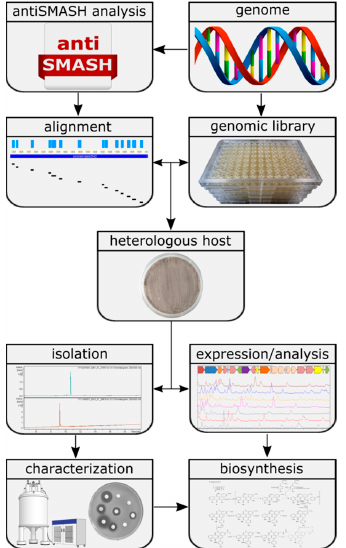
Figure 1. Workflow for the identification of novel natural products using genome mining.